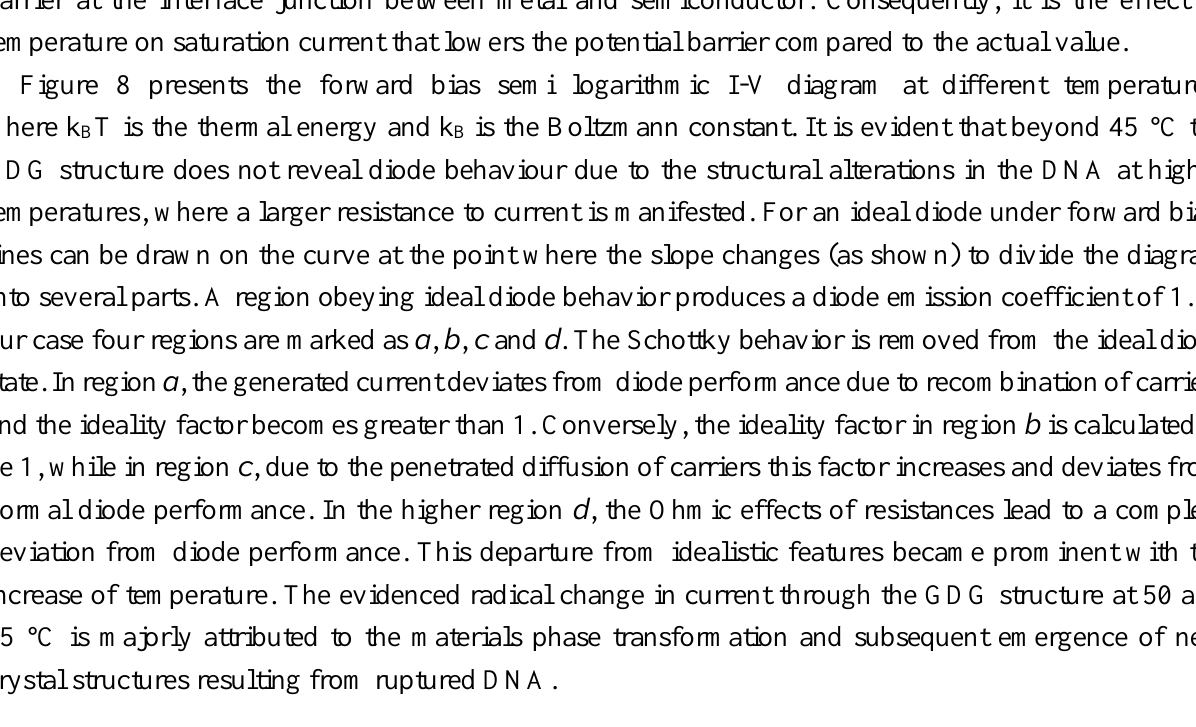
Figure 8. Temperature dependent current density without applied magnetic